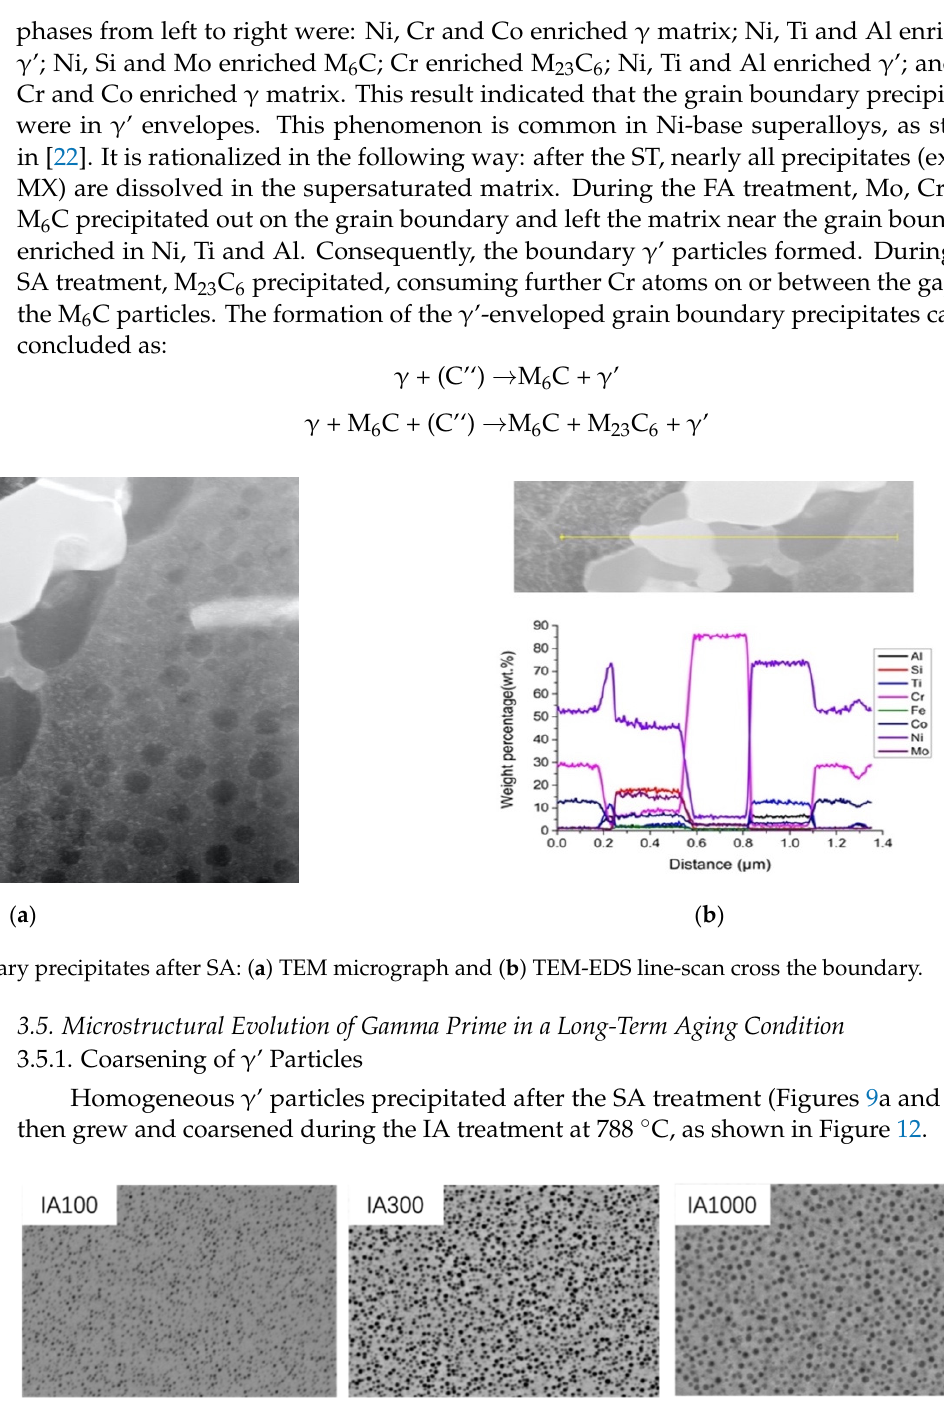
Figure 10. Micrographs of grain boundary precipitates in different isothermal aged samples.